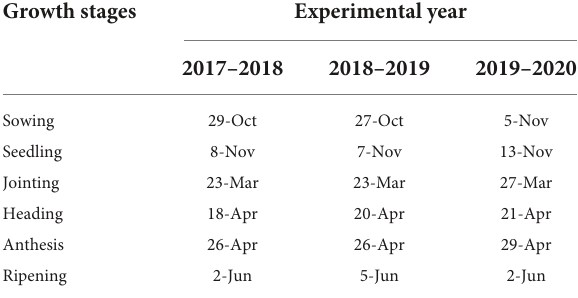
TABLE 2 Phenological phases of winter wheat according to the Zadoks staging system during the three experimental years from 2017 to